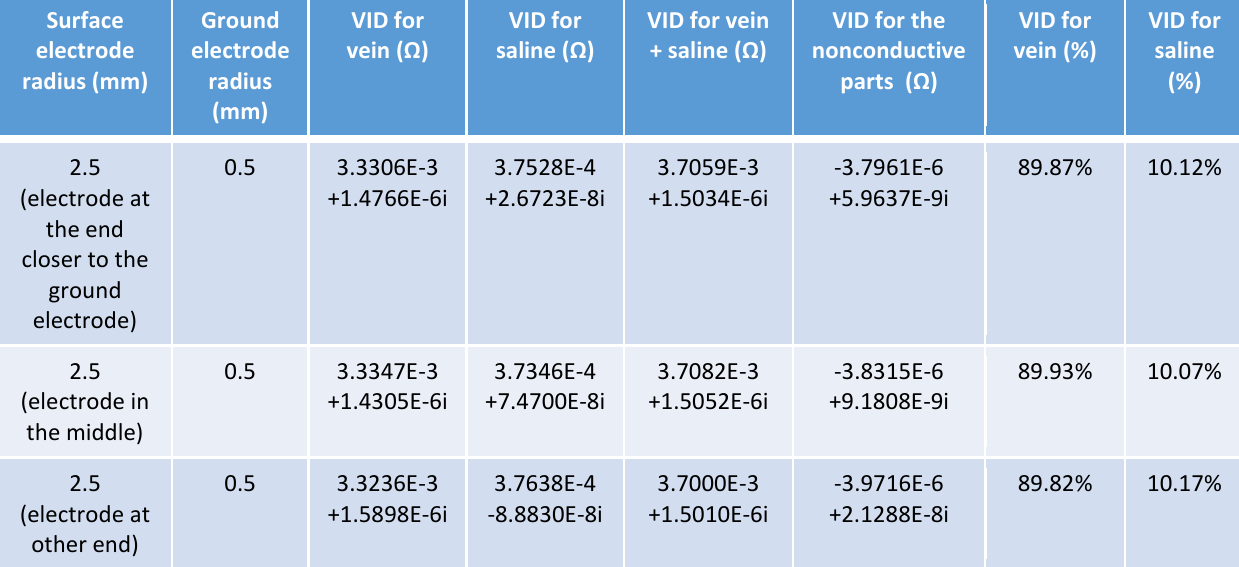
Table.6: Volume integration of Volume Impedance Density (VID) measurements at 1 MHz with one of the 28 surface electrodes as terminal (7 electrodes in 4